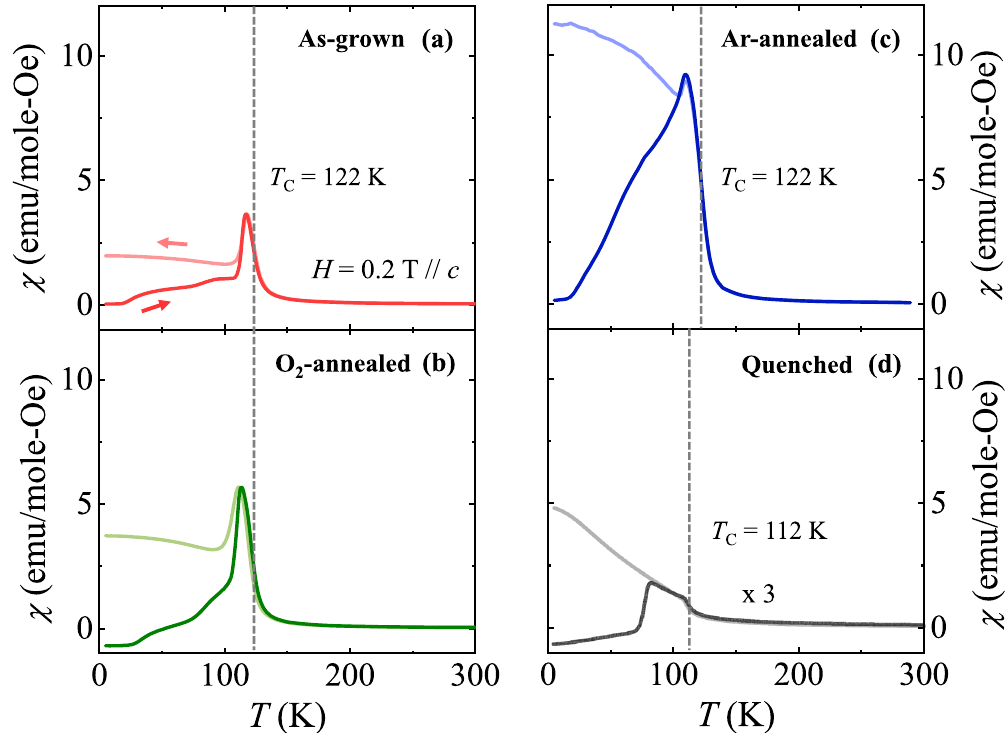
Figure 5. Magnetic susceptibility for the annealed crystals. Temperature dependence of ZFC and FC χ values displayed in linear scale along the c axis in H = 0.2 T for ( a ) the as-grown, ( b ) O 2 -annealed, ( c ) Ar-annealed, and ( d ) quenched crystals. The χ values are plotted after magnification by three times in scale for the quenched